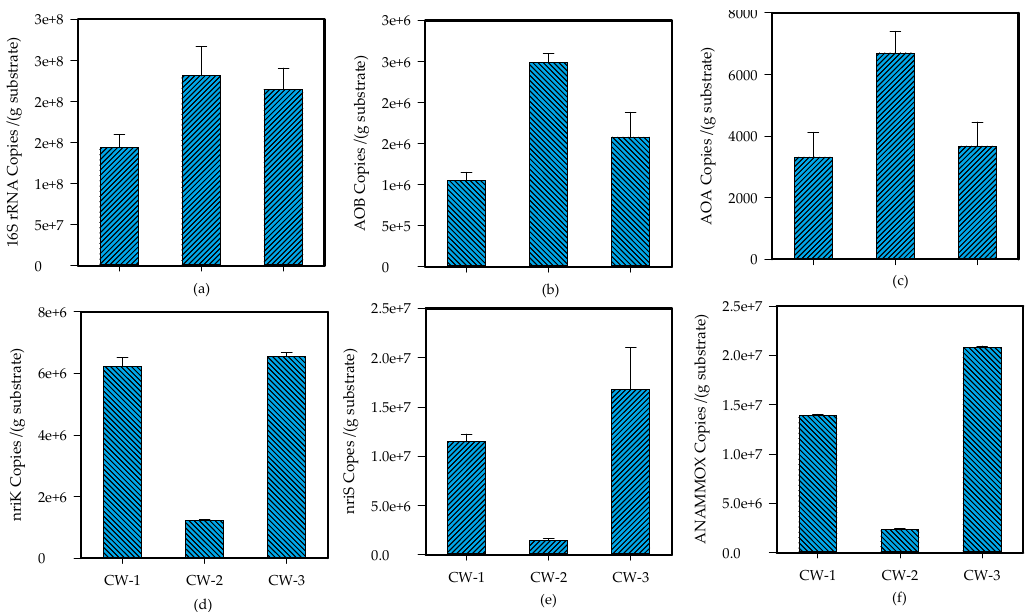
Figure 6. Gene copy number of 16S rRNA, AOB, AOA, nriK, nriS, Anammox. ( a ) 16S rRNA; ( b ) AOB; ( c ) AOA; ( d ) nriK; ( e ) nriS; ( f ) Anammox.